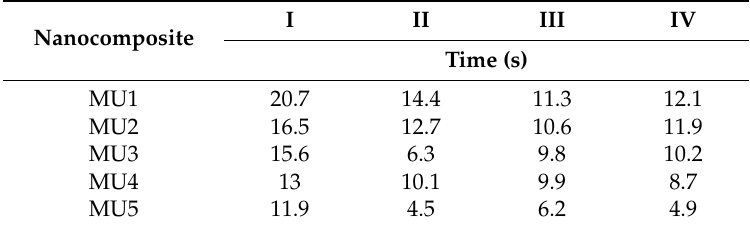
Table 9. Time of the permanent shape recovery after heating materials to 45 ◦